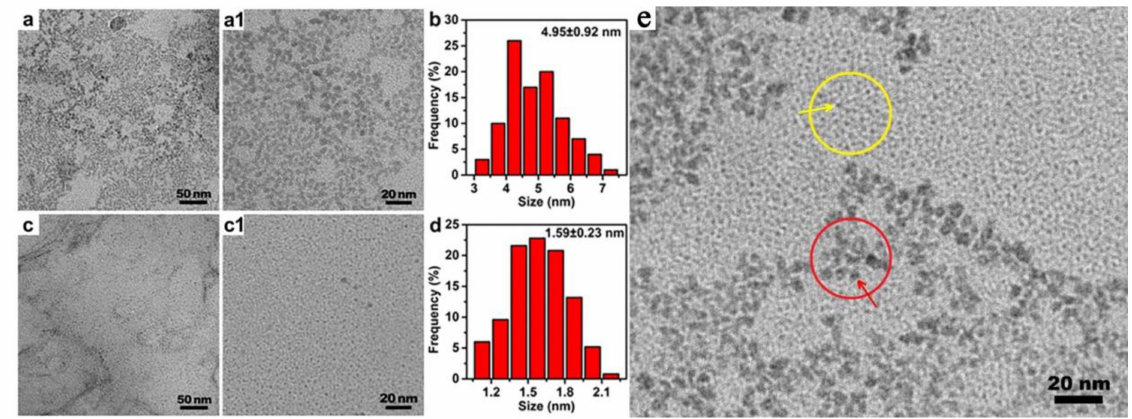
Figure 4. The representative TEM images ( a , a1 ) before and ( c , c1 ) after etching the Cu nanocrystals. The size distribution ( b ) before and ( d ) after etching the Cu nanocrystals. ( e ) TEM image of Cu NCs@AA during etching on a 20 nm scale